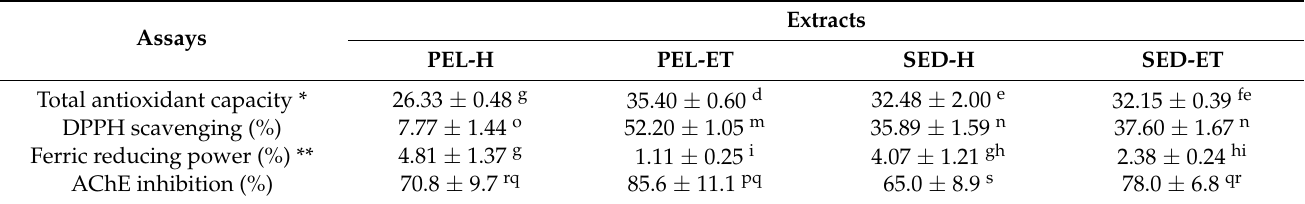
Table 4. Total antioxidant capacity, antioxidant activity determined by DPPH radical scavenging and ferric reducing power, and acetylcholinesterase inhibition of avocado peels and seeds. Assays